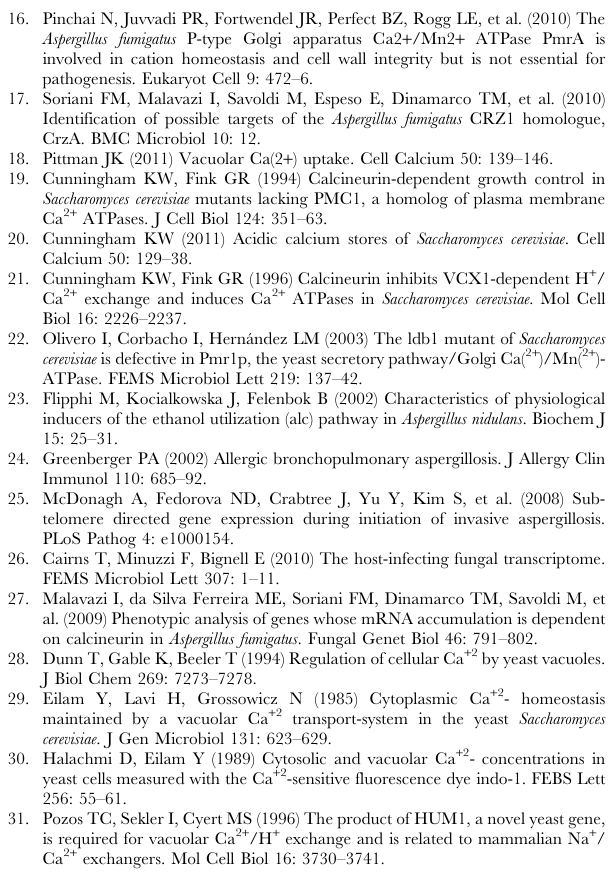
Figure S1 (A) Clustal alignment of A. fumigatus PmcA, PmcB, and PmcC. Figure S2 (B) CrzA-binding regions of the pmcA-C genes (upstream the ATG start codon). Underline and in bold the putative CDRE-motif. Figure S3 Southern blot and PCR analyses for (A) D vcxA , (B) D pmcB , (C) D pmcA and (D) alcA::pmcC.